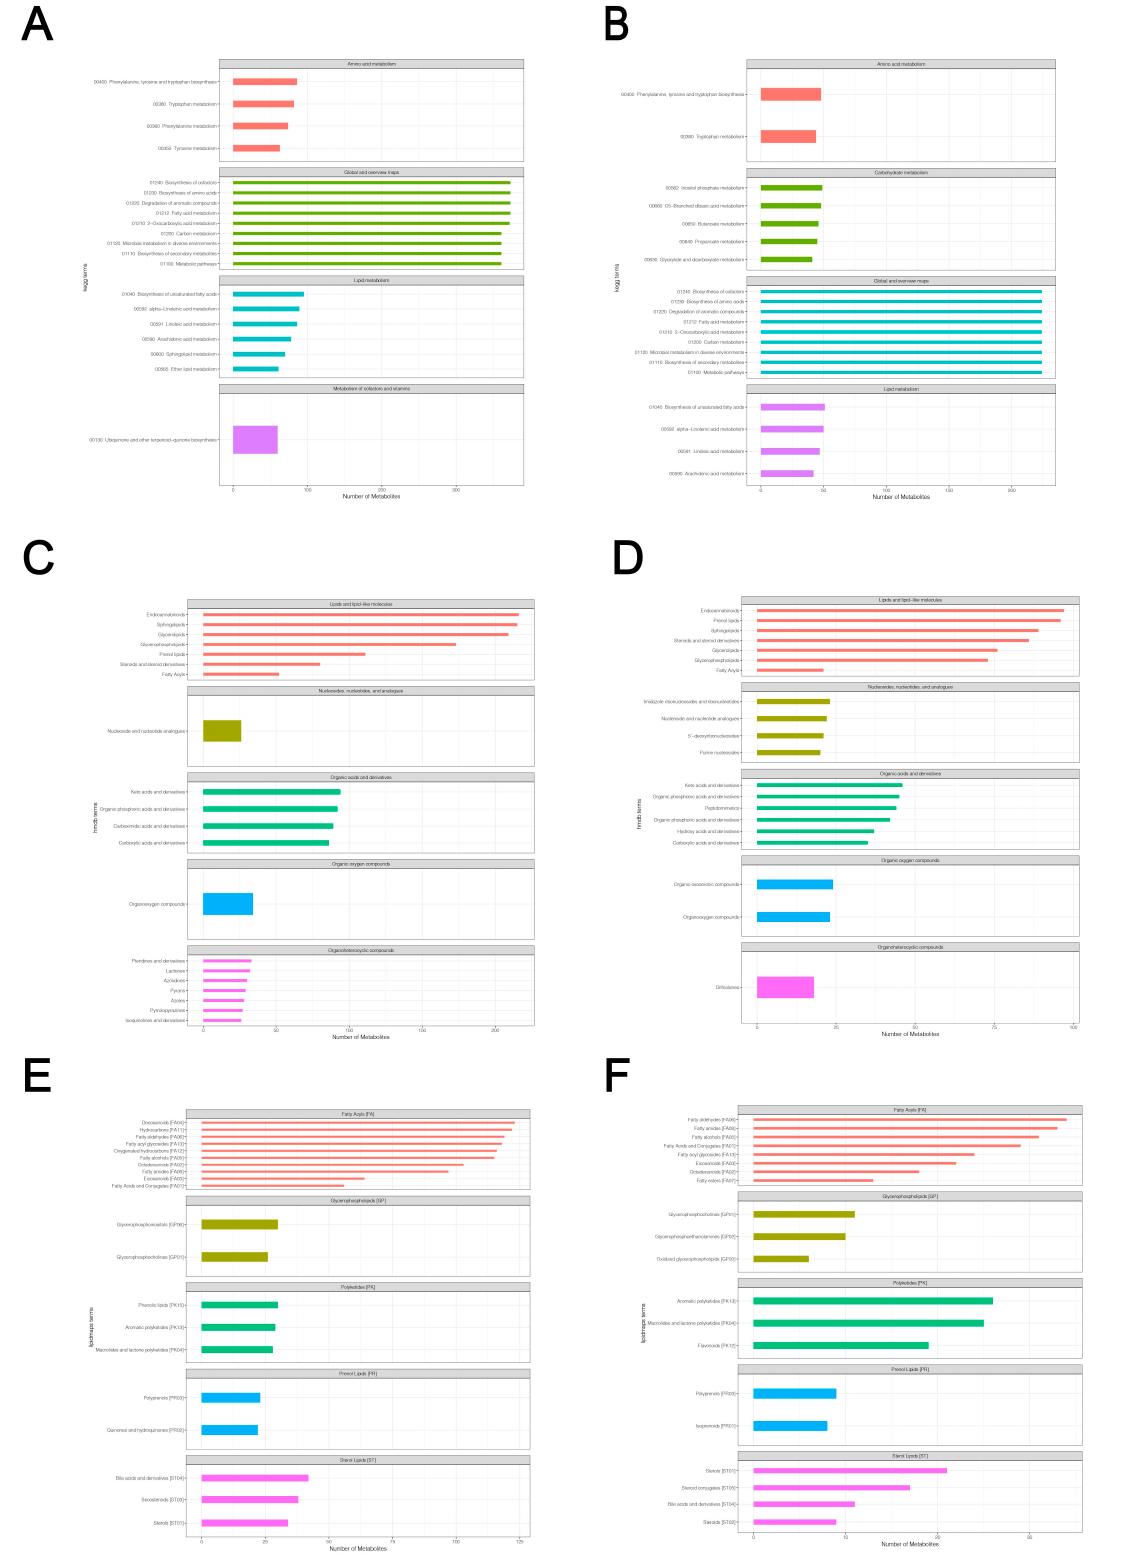
Figure 3. Total metabolite annotation results. ( A , B ) Annotation results of KEGG database in positive and negative ion mode. The entries under the same box in the figure represent the hierarchical classification annotation of KEGG pathways, corresponding to KO Pathway Level 1 and KO Pathway Level 2. ( C , D ) Annotation result of HMDB database in positive and negative ion mode. The entries under the same box in the figure represent HMDB level classification information, corresponding to the superclass and class information of HMDB database. ( E , F ) Lipid-MAPS database annotation results in positive and negative ion mode. The entries in the same box in the figure represent HMDB